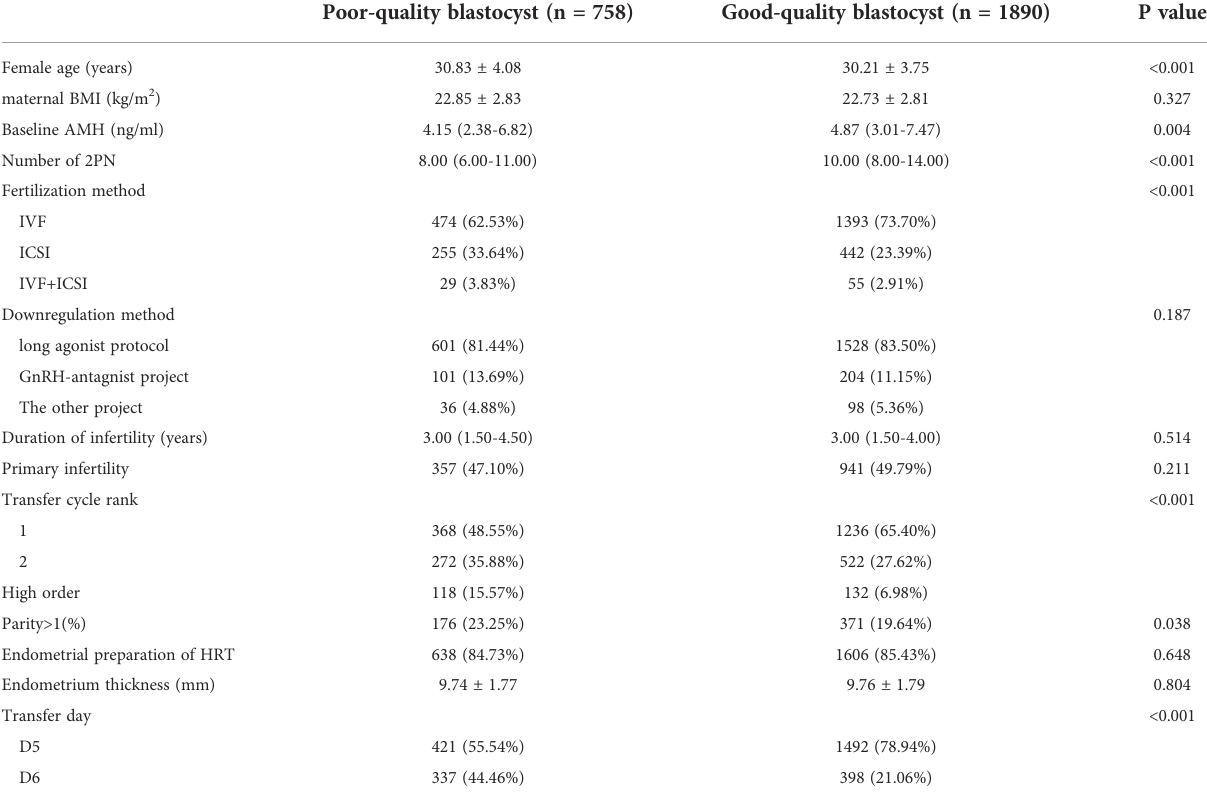
TABLE 1 Characteristics of patients with good or poor quality blastocyst